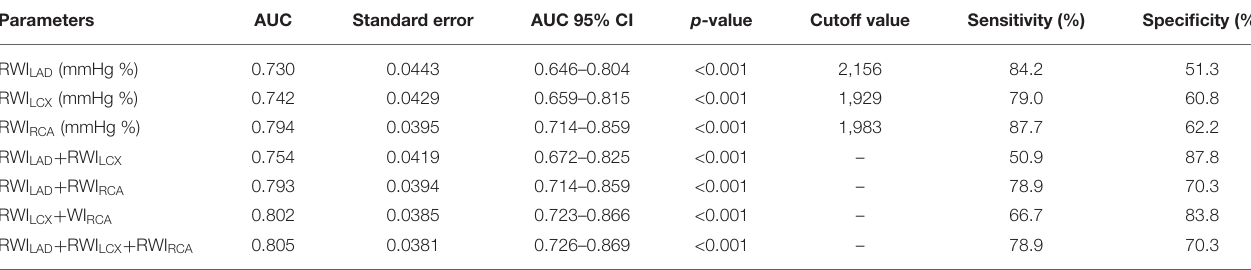
TABLE 5 | Receiver operating characteristic curve analysis of regional myocardial work parameters to identify high-risk SCAD.